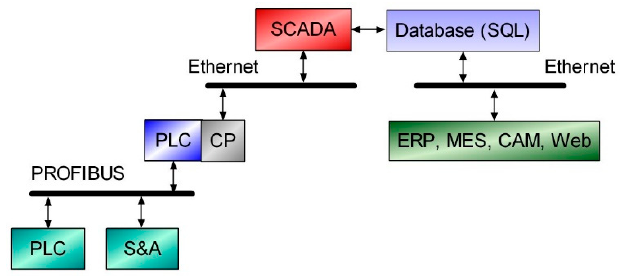
Figure 21. Block diagram of third-party applications to the SQL database.